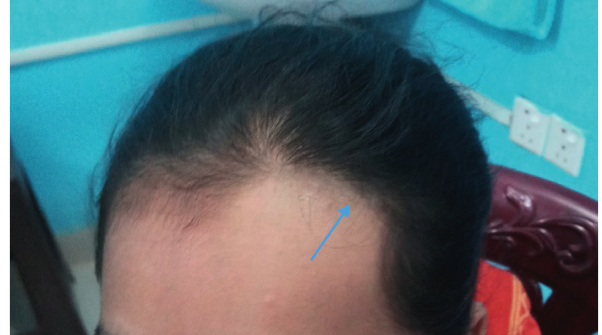
Figure 1: Hair loss over the forehead.